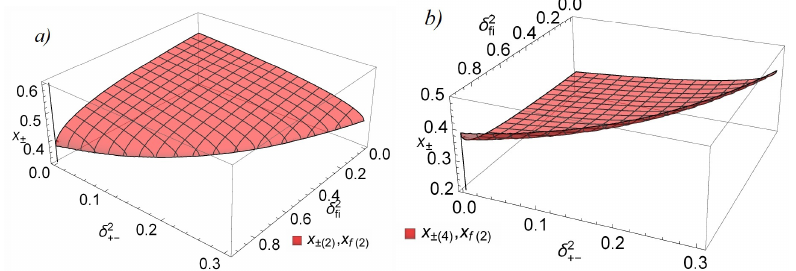
(cid:17) (cid:16) δ 2 , δ 2 + − (see fi (cid:16) (cid:17) δ 2 , δ 2 + − (see Expressions (23) and (24)) on the outgoing fi